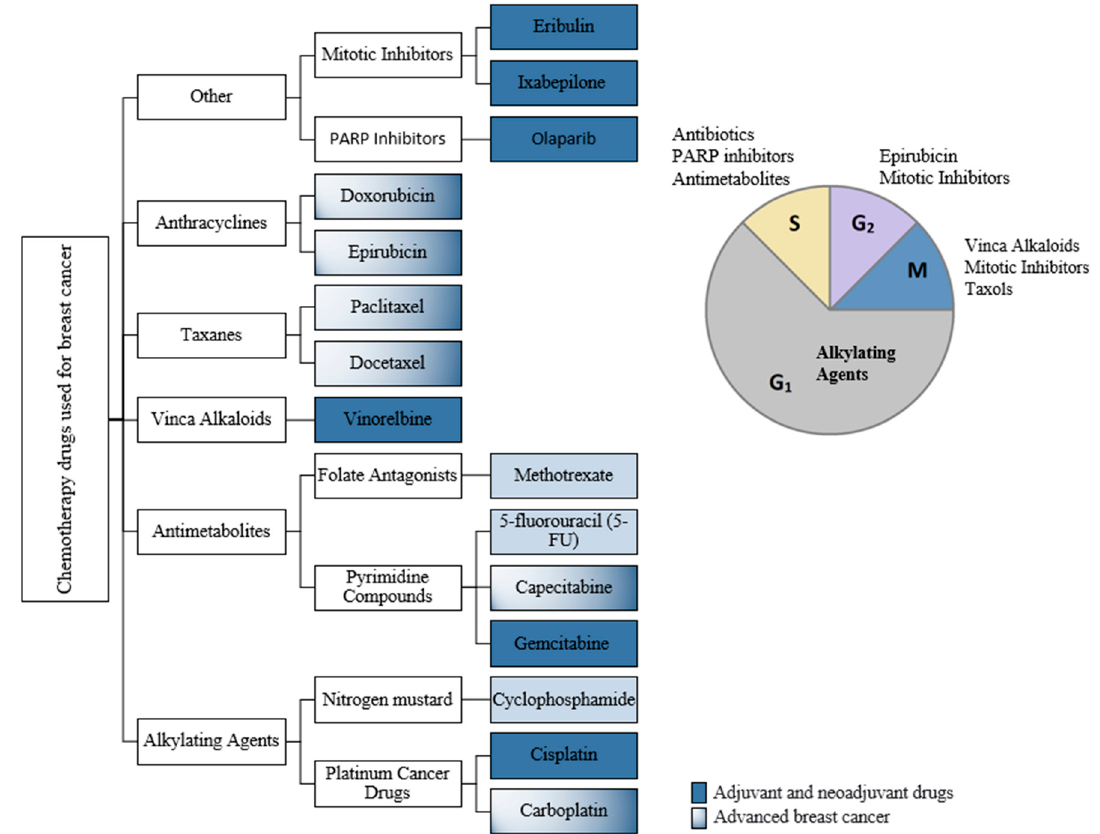
Figure 1. Classification of chemotherapy drugs used in breast cancer (BC) according to the cell- cycle-phase they are active